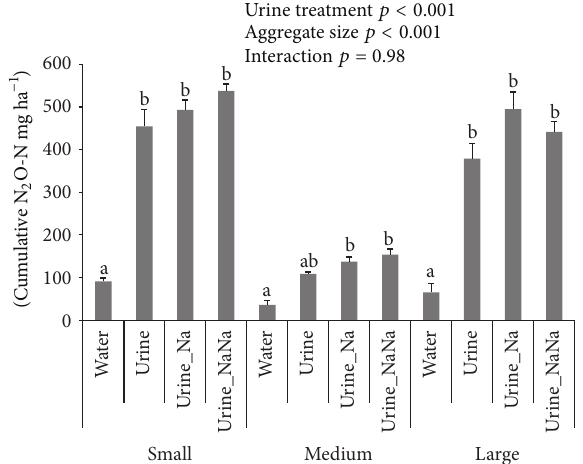
Figure 5: The effects of the urine application with different Na +